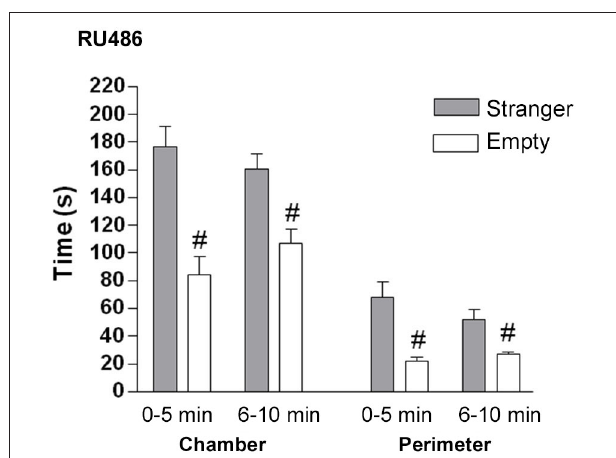
FIGURE 6 | The effect of MR (RU28318) antagonist on the sociability phase in male control mice. (A) Time in seconds, spent in the chamber with the stranger mouse (grey bar) and in the chamber with the empty cylinder (white bar) for total time in chamber and time in the perimeter